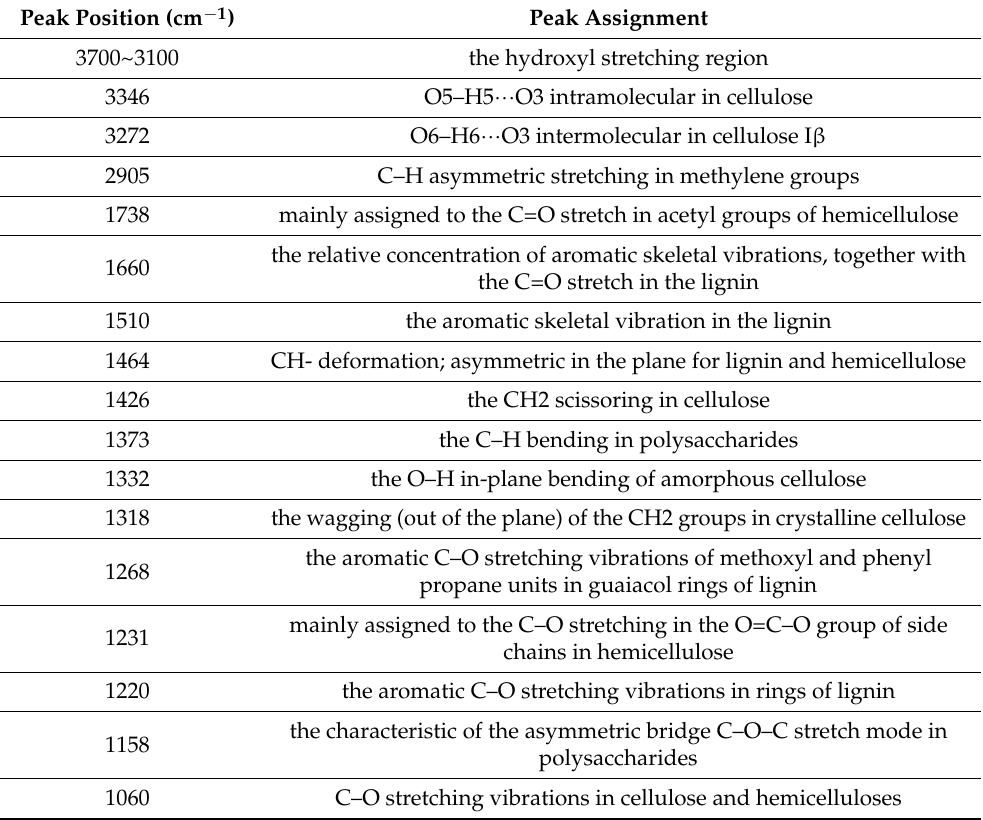
Figure 5. FTIR spectra of FR (reference fir sample, red line), WFS (visually sound waterlogged fir sample, yellow line), and WFD (visually degraded waterlogged fir sample, blue line). Table 2. Peak assignments for FTIR spectra of wood